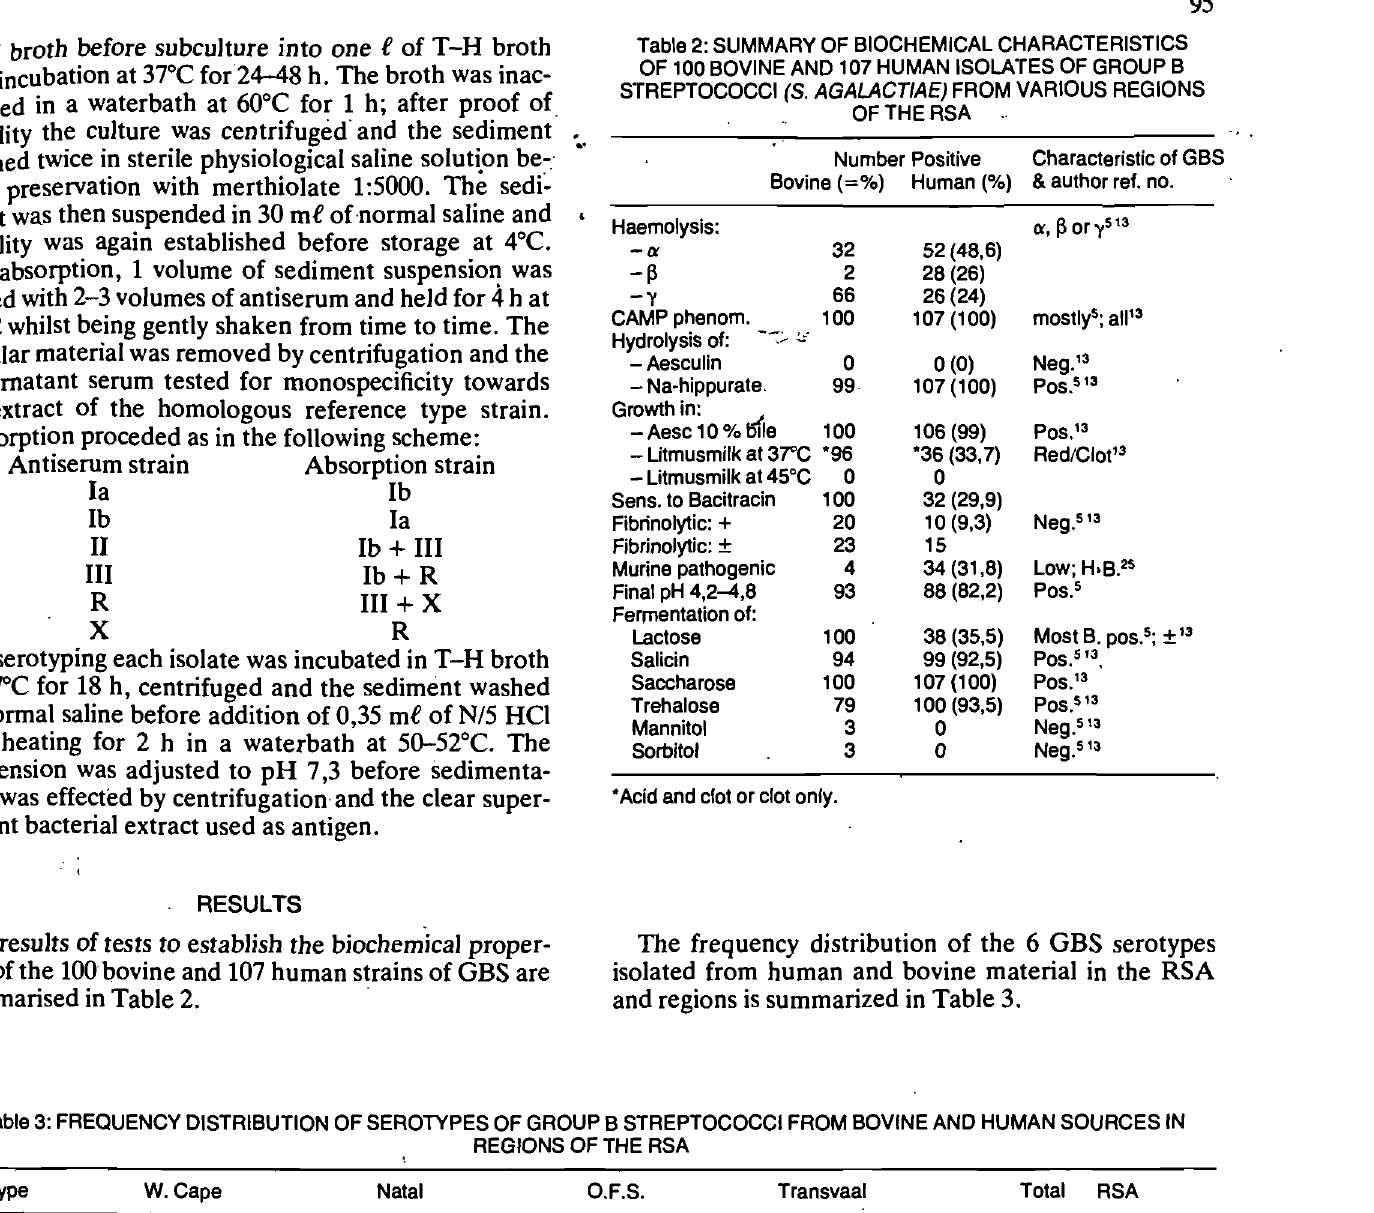
Table 3: FREQUENCY DISTRIBUTION OF SEROTYPES OF GROUP B STREPTOCOCCI FROM BOVINE AND HUMAN SOURCES IN REGIONS OF THE RSA Serotype W.Cape